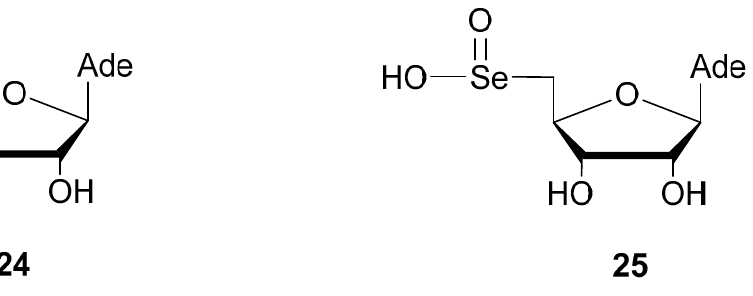
Figure 6. Se-containing products formed in the hydrolysis of dASeppA ( 1b